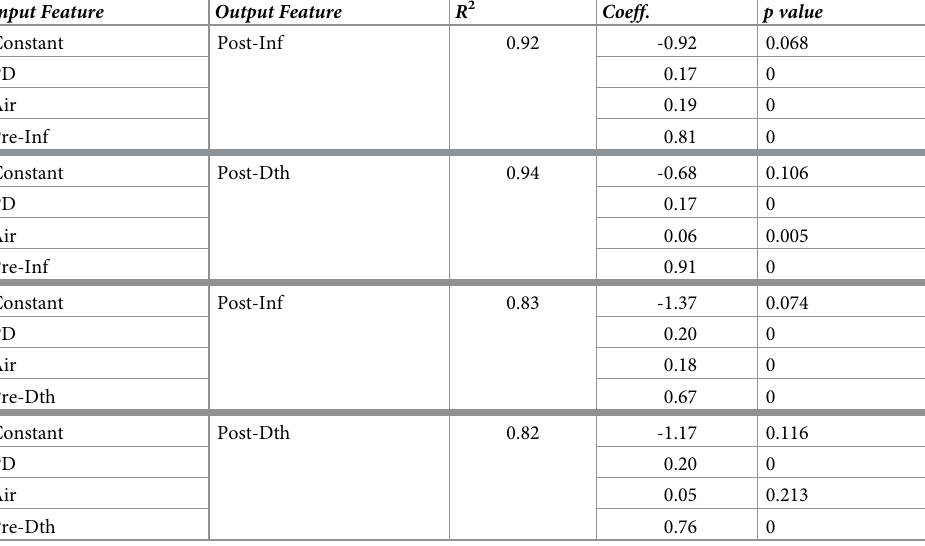
Table 3. Multiple linear regression table with R 2 , coefficient and p value for input features ( population